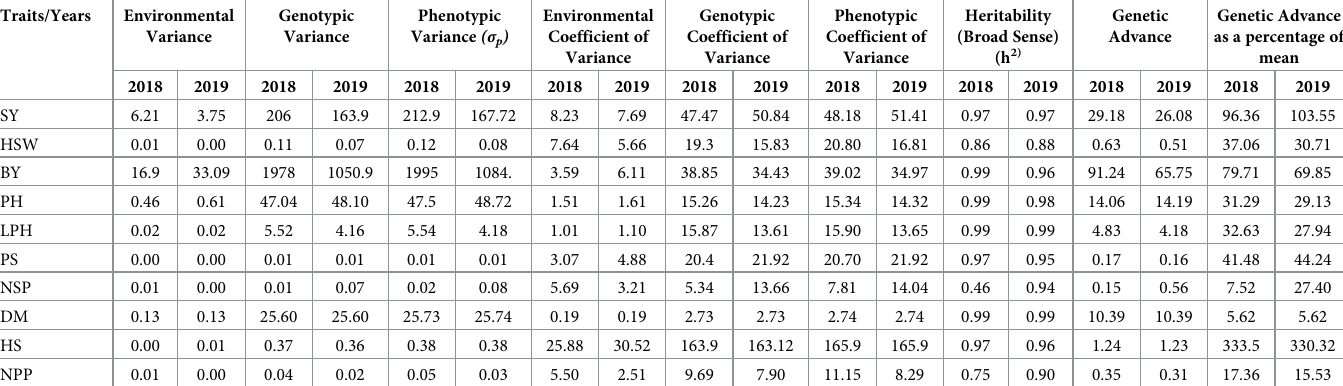
Table 6. Estimation of heritability and genetic advance for the years 2017–18 and